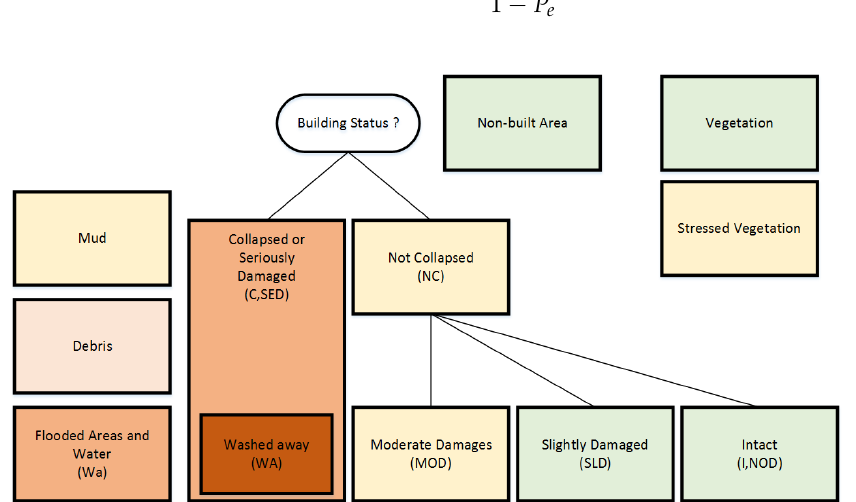
Figure 5. The main classes of damage that can be found in the artificial intelligence (AI) literature applied to the 2011 Tohoku tsunami. Note that, for building damage categories, there seems to be a hierarchy, and the “washed away” category can even be considered as a specific subset of the “collapsed building”